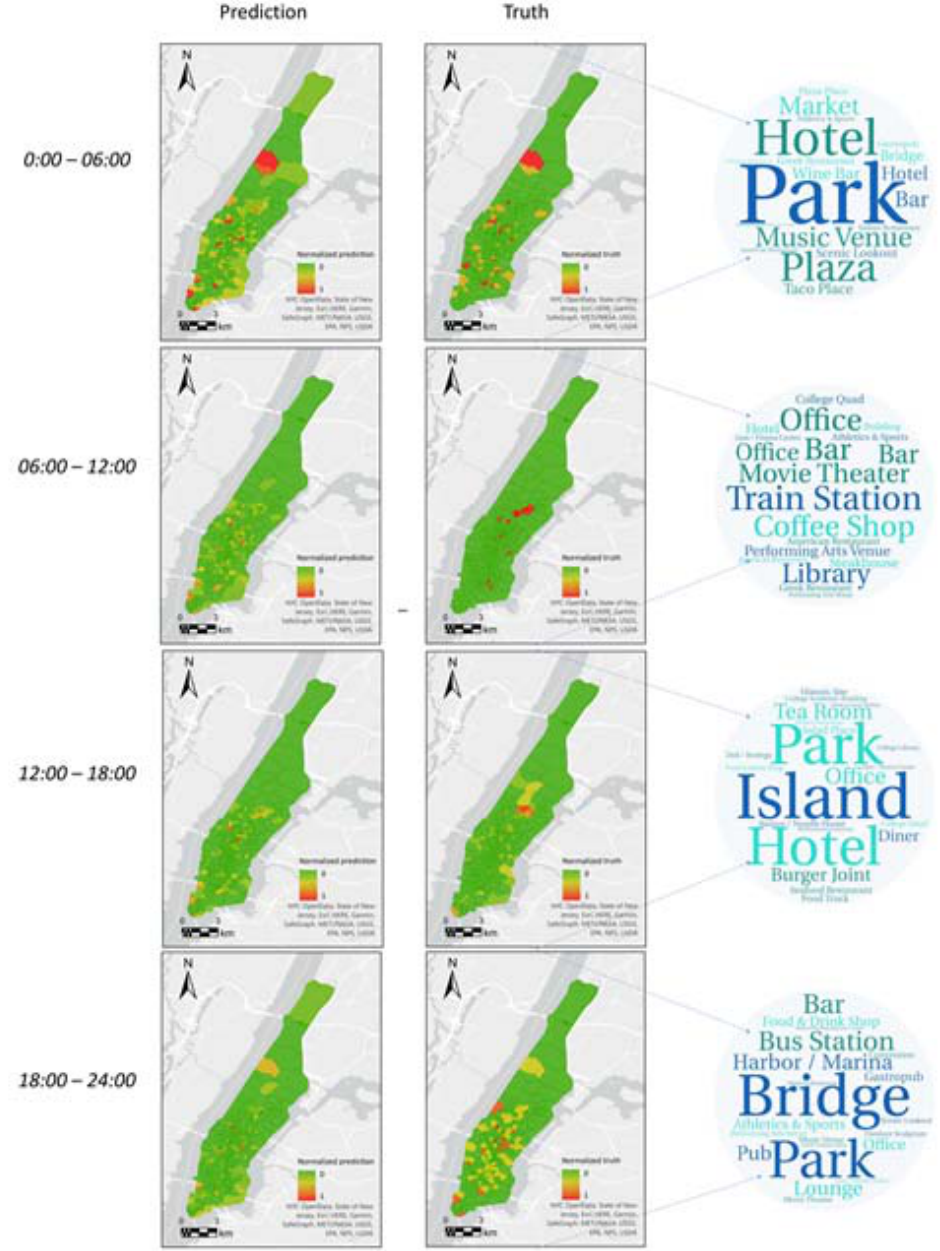
Figure 15. User activity intensity heat map. The values were normalized by the min-max method. The font size in the tag cloud corresponds to the significance of the POI type. The more significant the POI type, the larger the corresponding